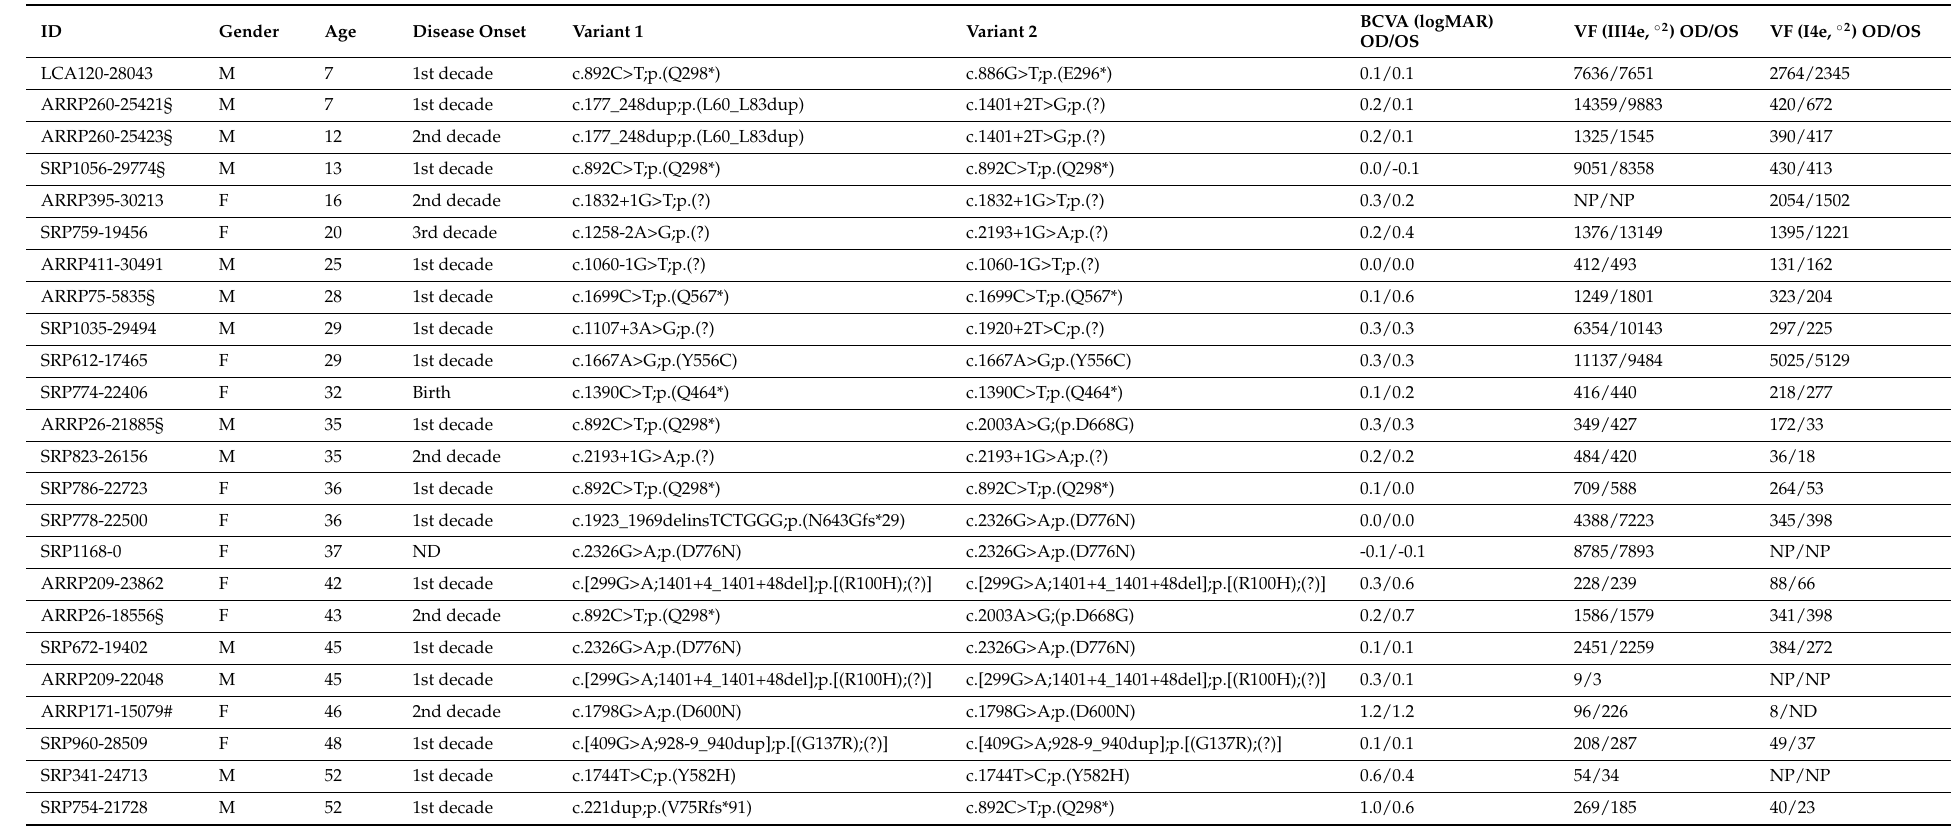
Table 1. Genetic and clinical findings in PDE6B -associated retinitis